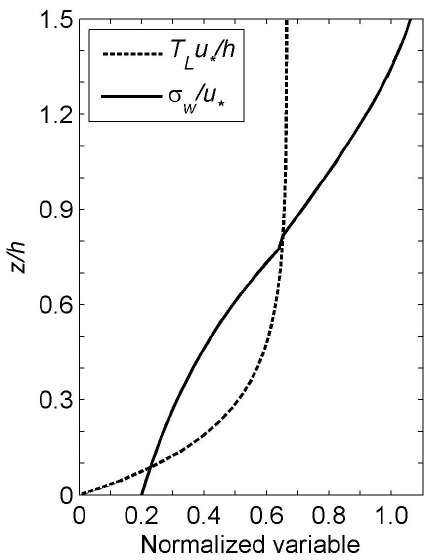
Fig. A1. Normalized profiles of Lagrangian time scale ( T L ) and standard deviation of vertical wind velocity ( σ w ) , calculated using the parameterizations proposed by Styles et al. (2002) and Leuning (2000),